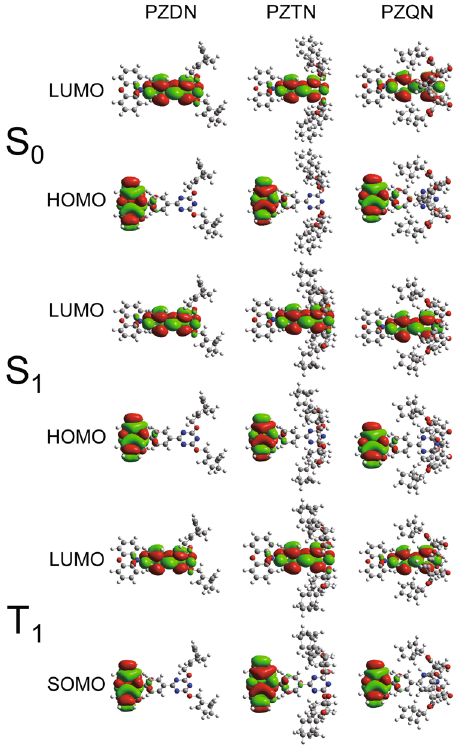
Fig. 3 Optimized frontier orbital contours of PZDN, PZTN, and PZQN in the S 0 , S 1 , and T 1 states. The S 0 state structures and excited state (S 1 , T 1 ) structures were calculated by density functional theory (DFT) and time- dependent density functional theory (TD-DFT), respectively, with the PBE0 hybrid functional and the 6 – 31 G(d) basis